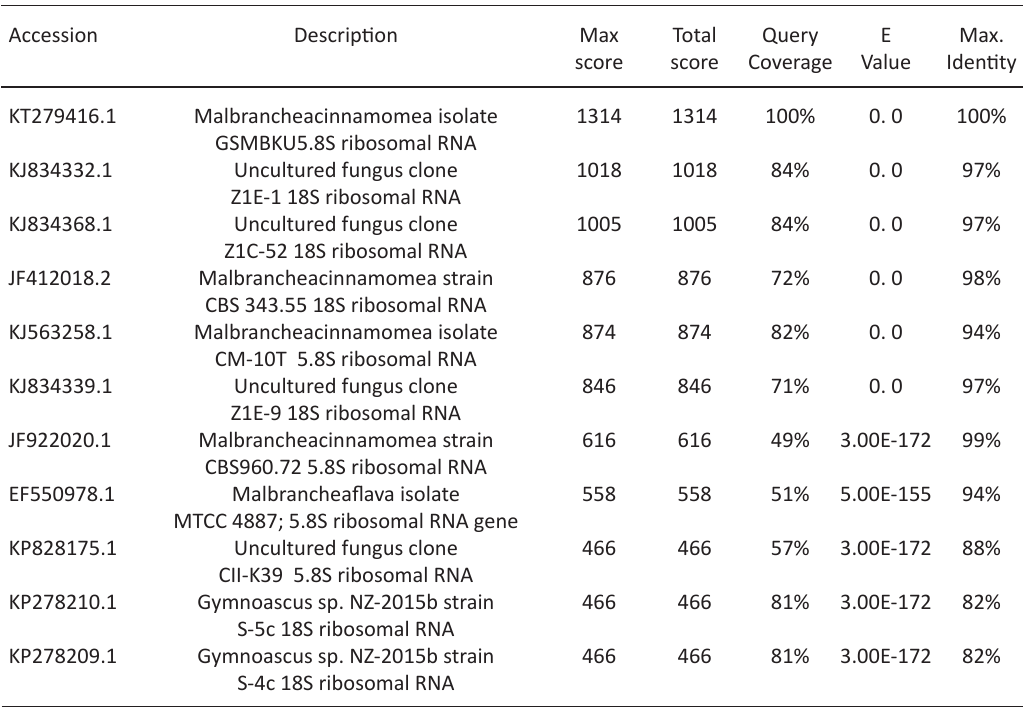
Fig. 4. Phylogenetic tree of Malbranchea